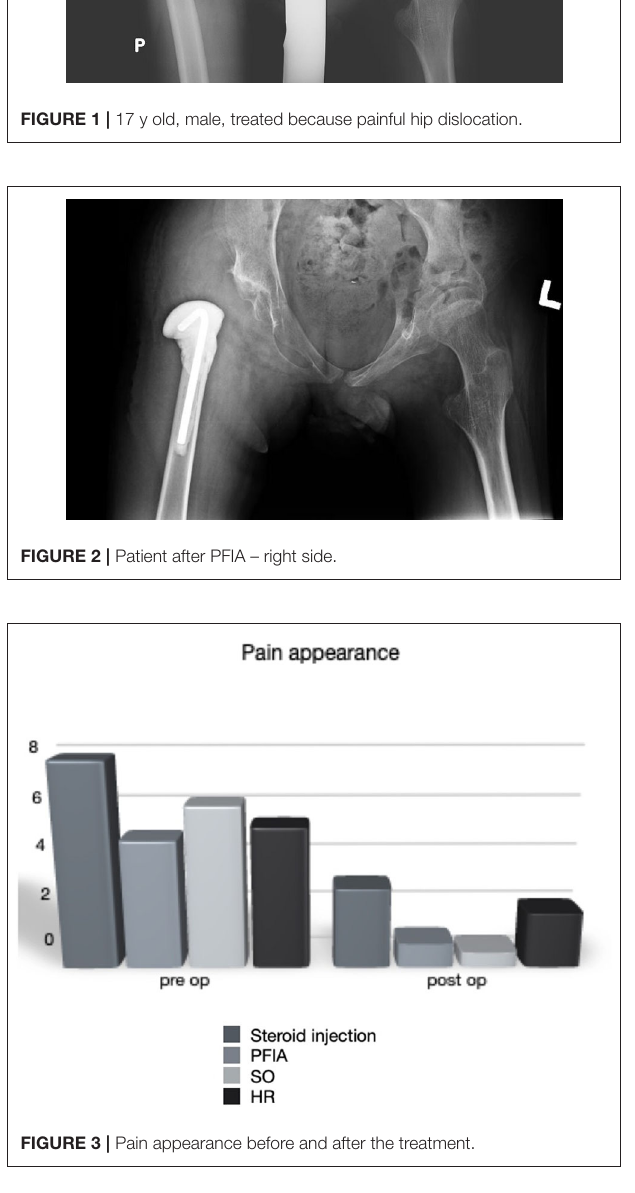
the surgical treatment, especially for the group of patients after PFIA ( p = 0.004).